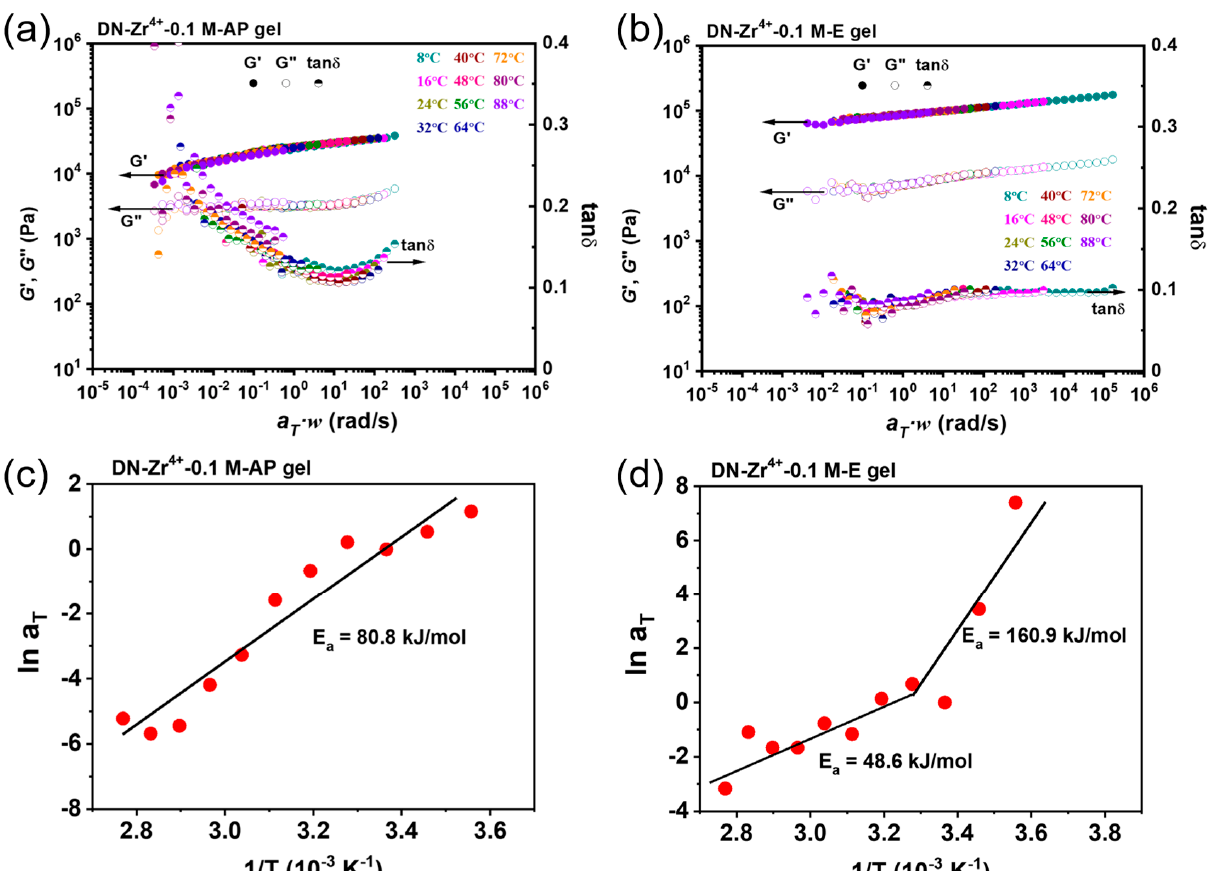
Figure 3. Master curves of the storage modulus G ′ , loss modulus G ″ , and loss factor tan δ of DN − Zr 4+ − 0.1 M − AP hydrogels ( a ) and DN − Zr 4+ − 0.1 M − E hydrogels ( b ). The measurements were performed from 0.1 to 100 rad/s at a shear strain of 0.2%, at different temperatures from 8 °C to 88 °C with an interval temperature of 8 °C , and the results were obtained by performing classical time– temperature superposition shifts at a reference temperature of at 24 °C, deduced from the data in Figure 2 using horizontal shift factor a T and without vertical shift. Arrhenius plot depicting the tem- perature dependence of the shift factors a T used for generating master curves of DN − Zr 4+ − 0.1 M − AP hydrogels ( c ) and DN − Zr 4+ − 0.1 M − E hydrogels ( d ). The apparent activation energy values were cal- culated from the slope of the curves.